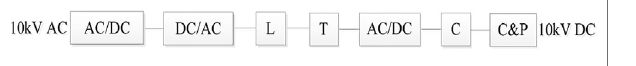
FIGURE 11 | Port reliability evaluation model of 10 kV AC-10 kV DC port.